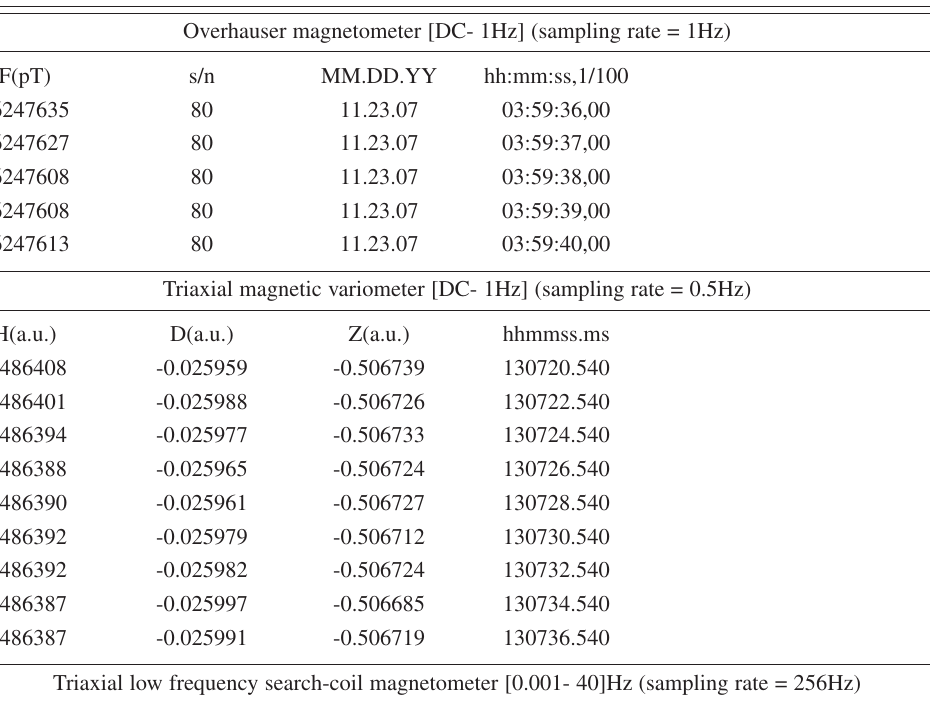
Table I. Timestamps of three